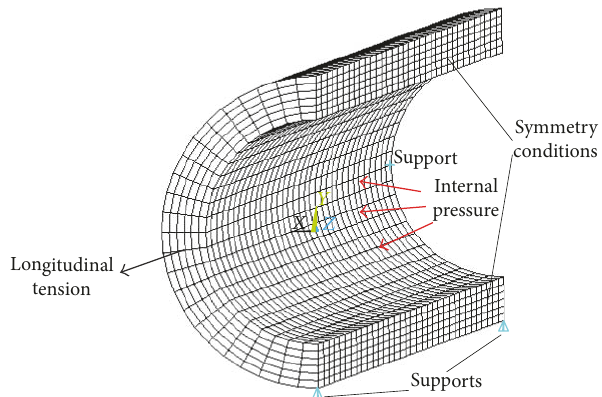
Figure 2: Structural model division into finite elements and assumed boundary